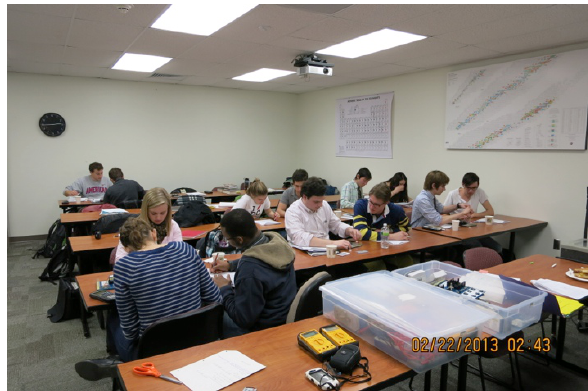
Figure 1. Teams of students working with electric circuits.